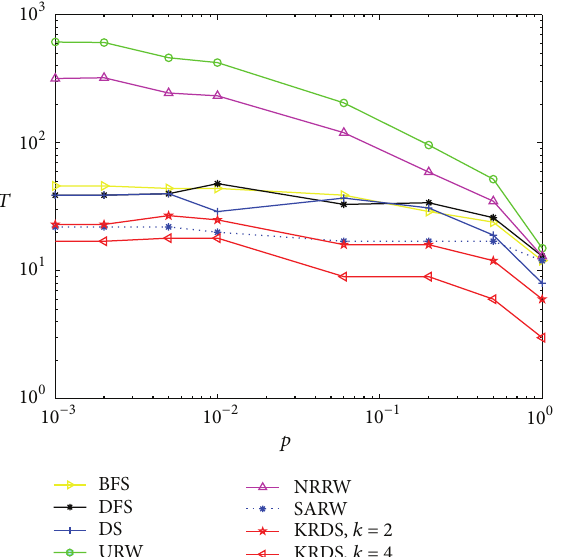
Figure 8: Plot of the average number 𝑇 of search steps versus the network size 𝑁 of the BASFN in the log-log